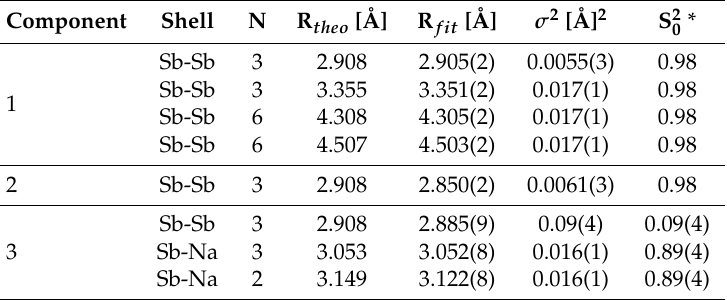
Table 4. EXAFS fitting parameters for the reconstructed MCR